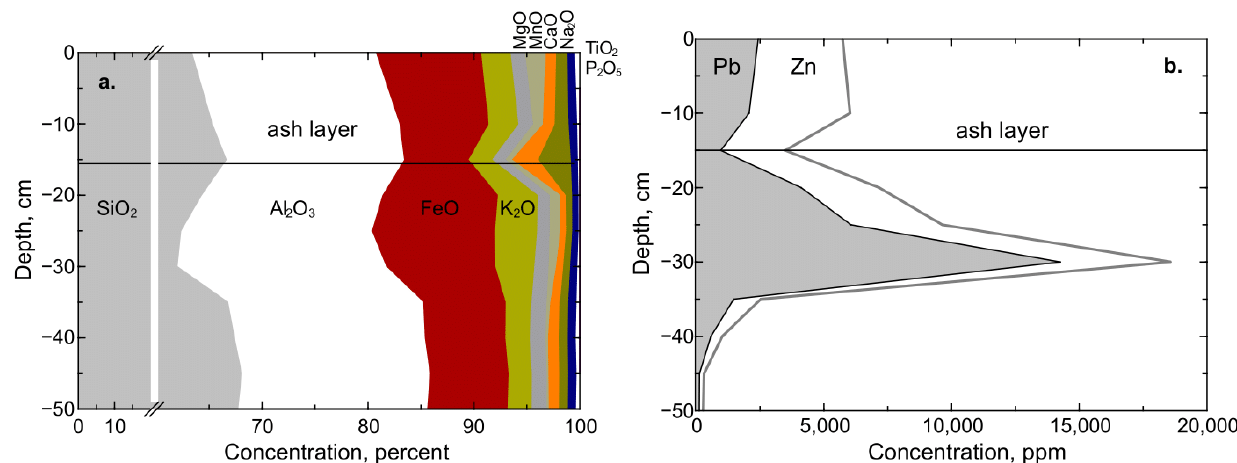
Figure 2. Cumulative area graphs of major (a) and trace element (b) concentrations for sediments collected from Aberdeen Lodge Bay in Coeur d’Alene Lake (modified from [21]). Major elements are normalized to 100 percent. Trace element concentrations are not normalized. Ash layer is from the Mount St. Helen’s eruption (1980).